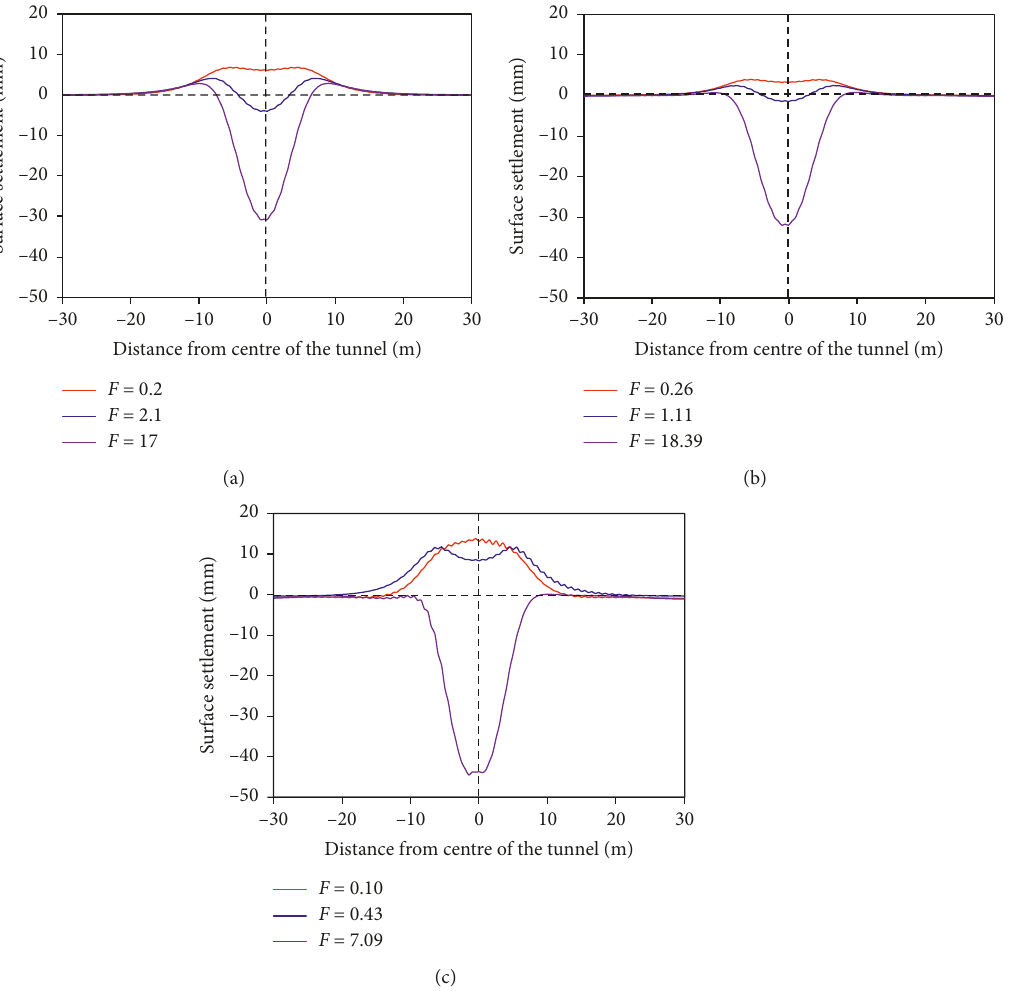
Figure 17: Surface settlement envelope for (a) Loma Prieta, (b) Nahanni, and (c) Chi-Chi